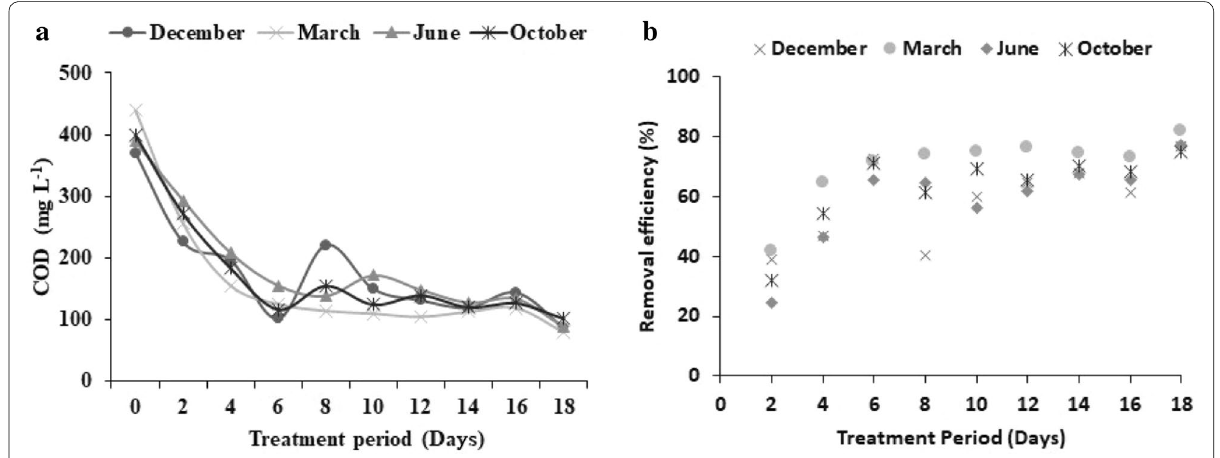
Fig. 6 Profile of COD concentrations ( a ) and uptake efficiencies ( b ) over the experimental